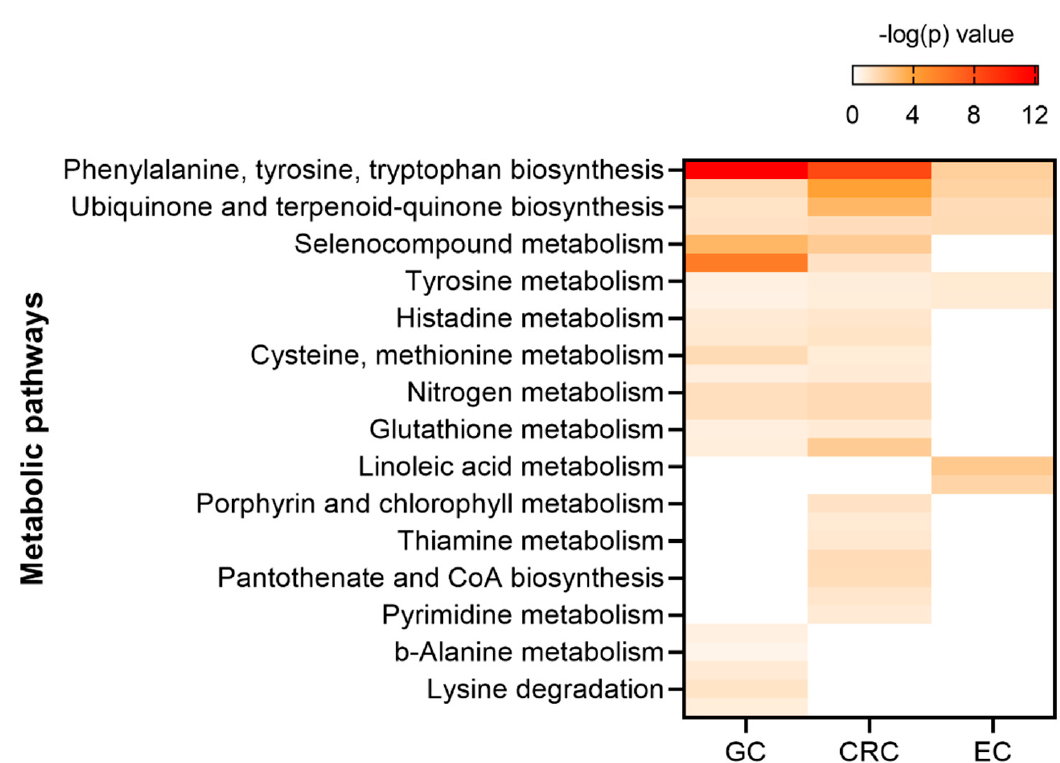
Figure 7. Comparison of the altered metabolic pathways for GC, EC and CRC. The metabolites demonstrated in Table 9 were uploaded to map to KEGG metabolic pathways for over-representation analysis and pathway topology analysis. − log(p) value represents the relevance and weight.